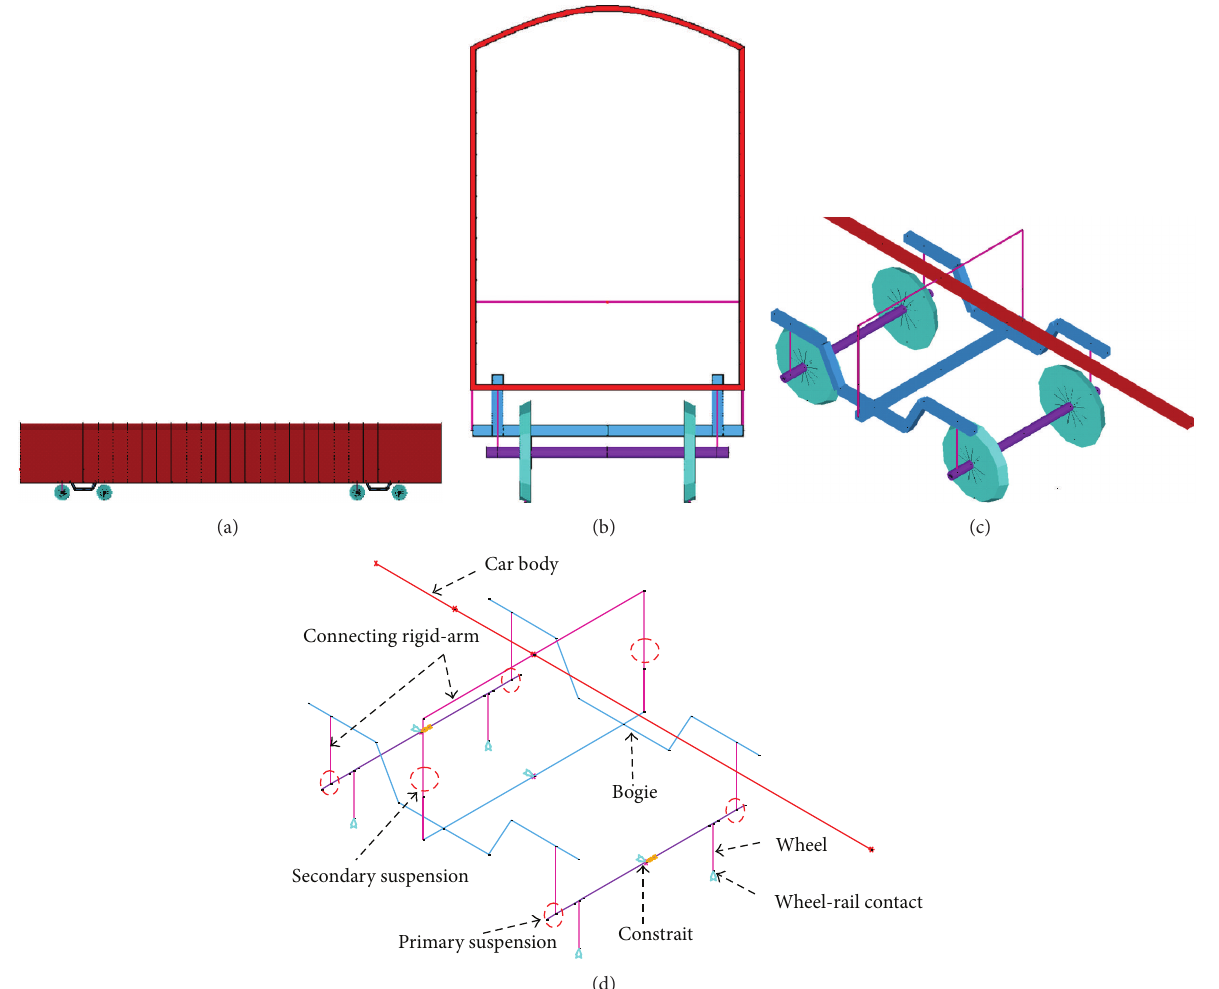
Figure 4: Finite element model of a railway vehicle: (a) elevation view; (b) side view; (c) isometric view; (d) model details